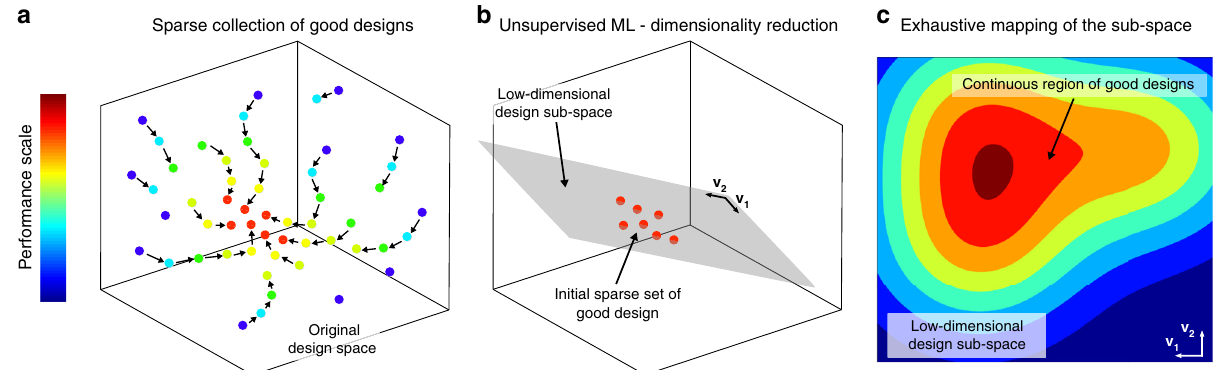
Fig. 1 Mapping of a high-dimensional design space. The procedure in three stages is conceptually illustrated. a An initial sparse collection of good designs (red circles) is found by optimization (here, random re-start — as indicated by blue circles — followed by local search) in the original high-dimensional design space. A trained machine-learning predictor is used in conjunction with the optimizer to speed up the search by quickly identifying promising design candidates as starting points for the optimizer (see the Methods section). b Dimensionality reduction (e.g., principal component analysis) is employed to reveal the lower-dimensional sub-space where the good designs with high-performance reside, shown here as a hyperplane de fi ned by the vectors V 1 and V 2 . c The low-dimensional design sub-space can be exhaustively mapped. For the continuum of the designs in the sub-space (that includes also the initial sparse set), a complete characterization is made possible by computing both the performance criterion selected for optimization and any additional metric. Vectors V 1 and V 2 are the same as in b and are reported for